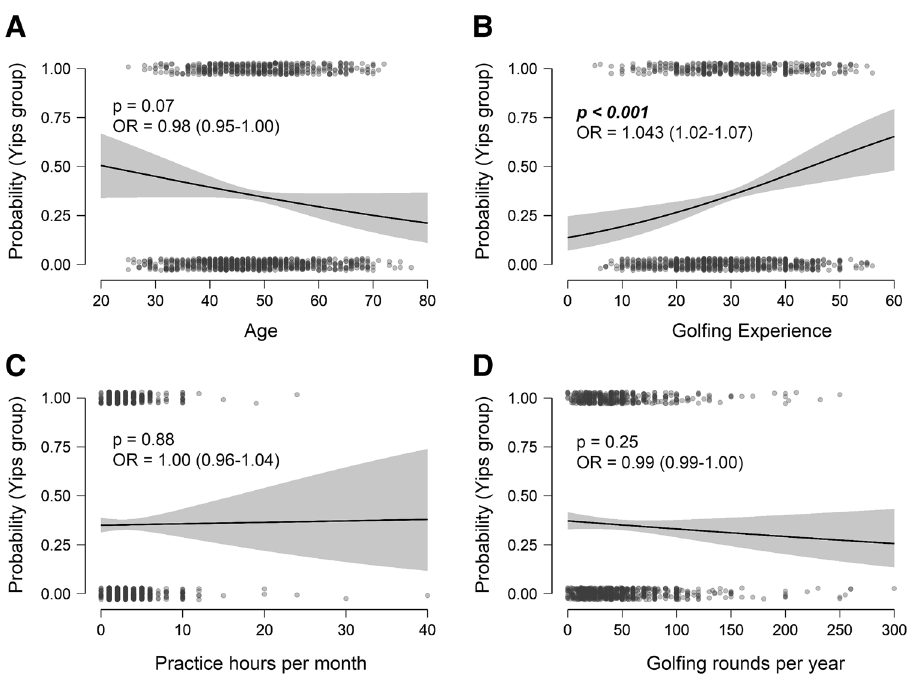
Figure 1. Multiple logistic regression of demographic predictors for yips. Conditional estimates plot for ( A ) age, ( B ) golfing experience, ( C ) practice hours/month and ( D ) rounds/year. OR = Odds ratio with confidence intervals for odds ratio. Yips groups coded as 1. Golfers with yips: N = 450, golfers without yips: N =